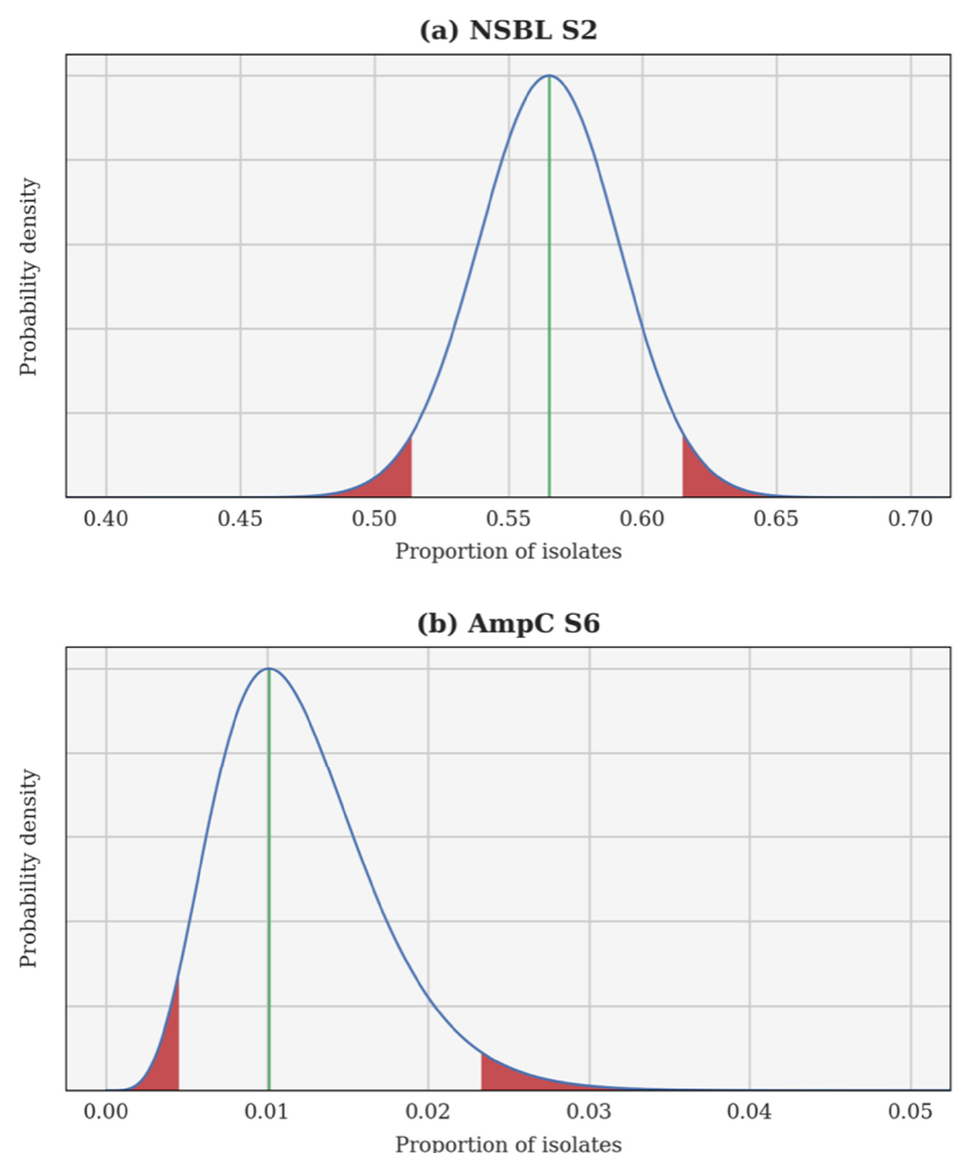
Figure 1. A posteriori probability density function of the theoretical proportion of resistant isolates p for the 2nd season narrow-spectrum β -lactamase (NSBL) ( a ) and for the 6th season cephalosporinase (AmpC) ( b ). In each case, the density is drawn using a continuous blue line, a vertical green line shows the maximum a posteriori, and the 95% confidence interval is delimited in red.